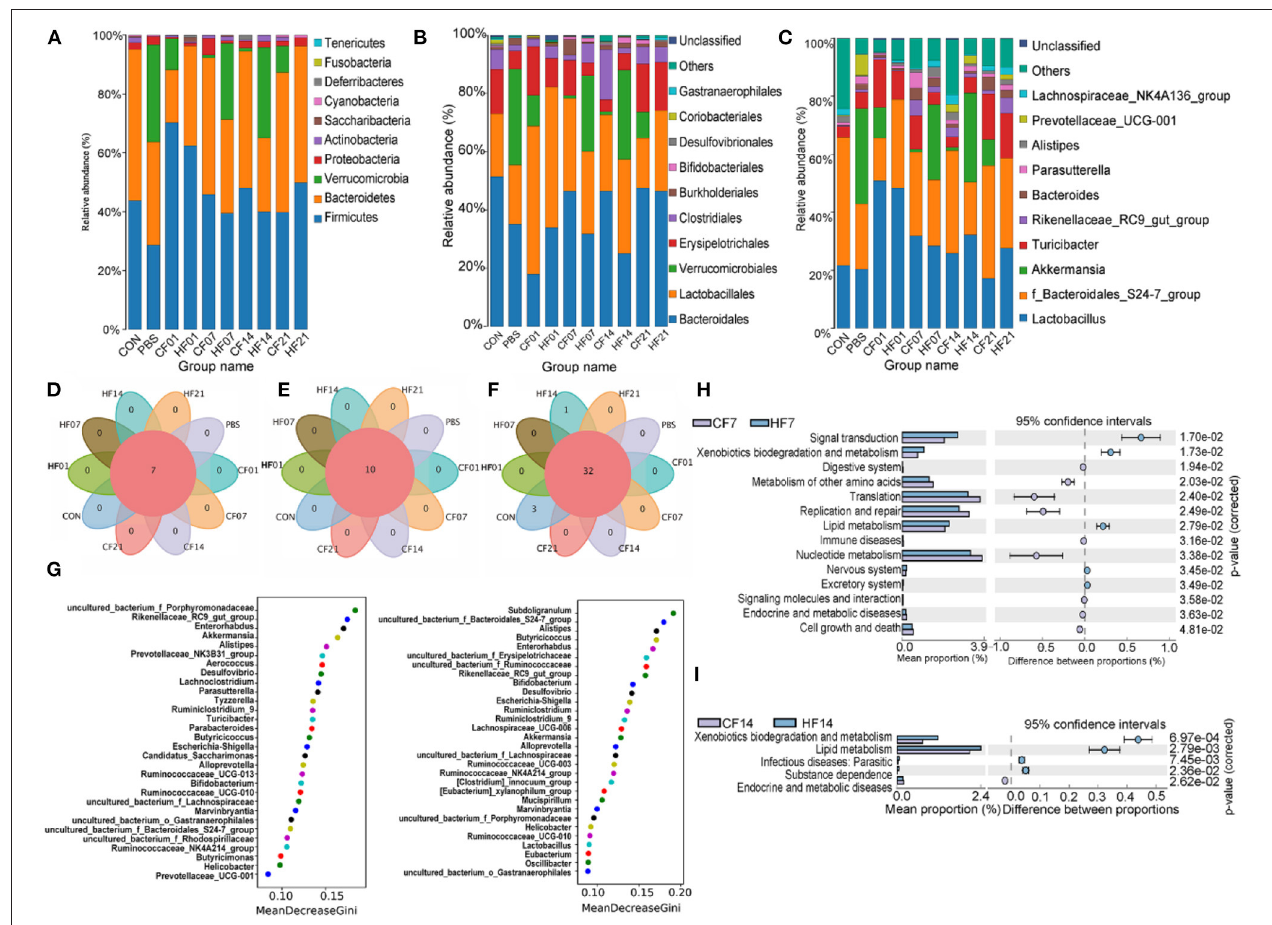
FIGURE 9 | Effects of heat stress on mice colonic species composition. (A) Intestinal microbiota structure by phylum; (B) Intestinal microbiota structure by class; (C) Intestinal microbiota structure by genus; (D) Venn analysis by phylum; (E) Venn analysis by class; (F) Venn analysis by genus; (G) Random forest distribution analysis on day 7 and day 14; (H) KEGG functional difference prediction (CF7 vs. HF7); (I) KEGG functional difference prediction (CF14 vs. H1F4). CF & HF refer to infusion with feces from control– and HS animals, respectively; 1, 7, 14, and 21 refer to sampling days of pig feces and mouse transplantation.